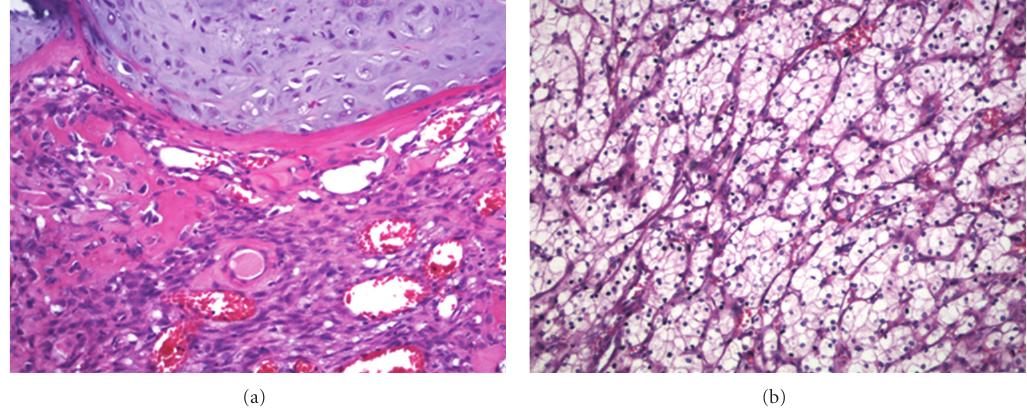
Figure 2: (a) Biopsy specimen of the proximal left femur of a 76-year-old Caucasian female with diagnosis dedi ff erentiated chondrosarcoma (400x), H.E. (b) same patient, clear-cell renal cell carcinoma of the right kidney (400x),